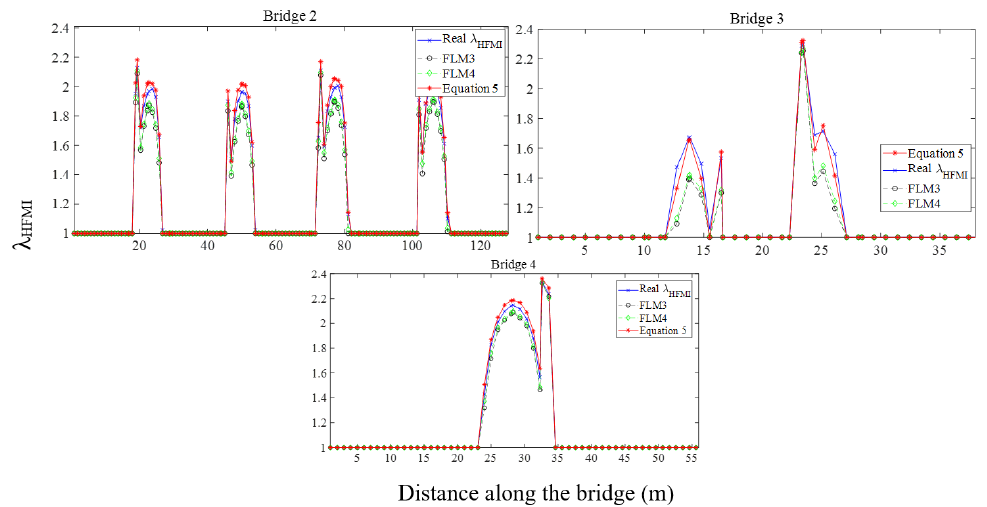
Figure 18. Calculated λ HFMI for the top flanges and mid-supports of the case study bridges (real λ HFMI was calculated using the original Swedish data pool).